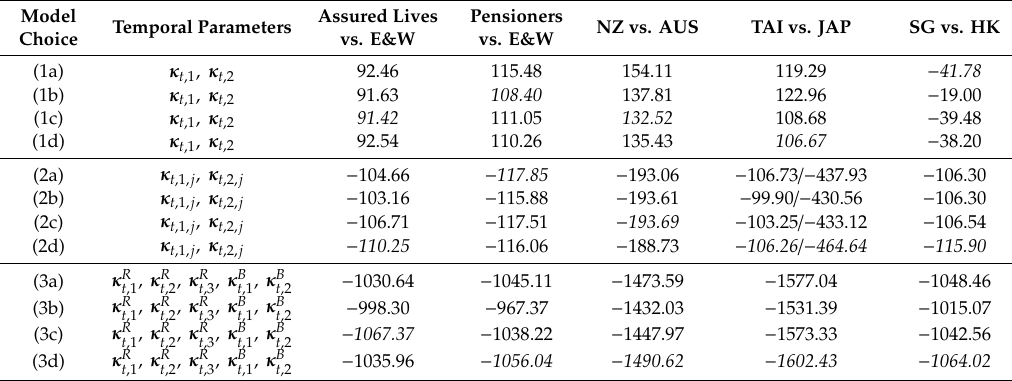
Table A1. AIC values of fitting various time series processes under di ff erent mortality projection models for di ff erent datasets.